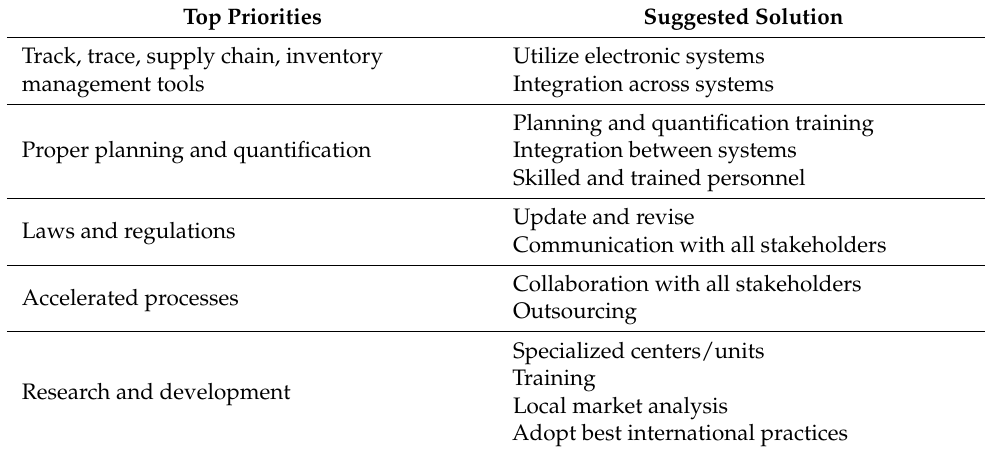
Table 5. Summary of the suggested solutions and Priorities for the Future State